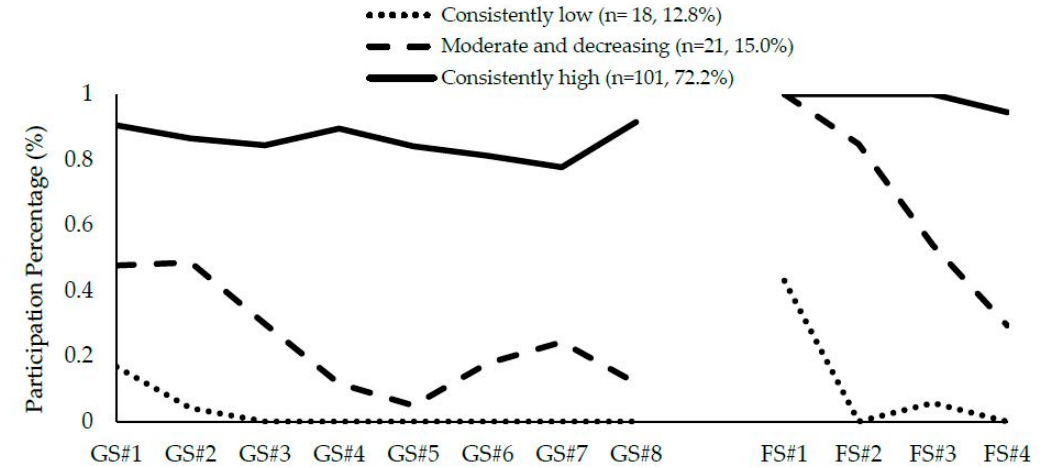
Figure 1. Heterogeneity in attendance patterns for Familias Unidas for Health and Wellness. GS = group session, FS = family session.